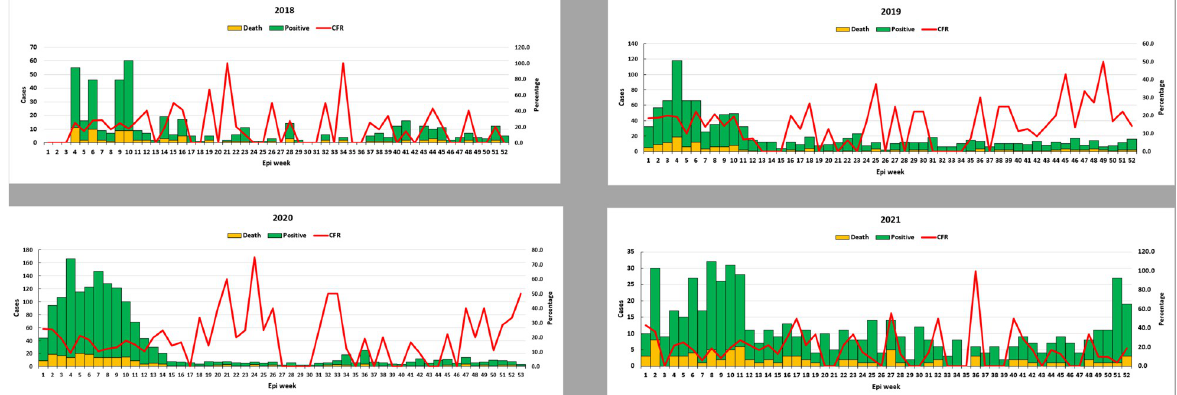
Fig 3. Weekly distribution of confirmed cases, deaths, and case fatality rates, 2018–2022.